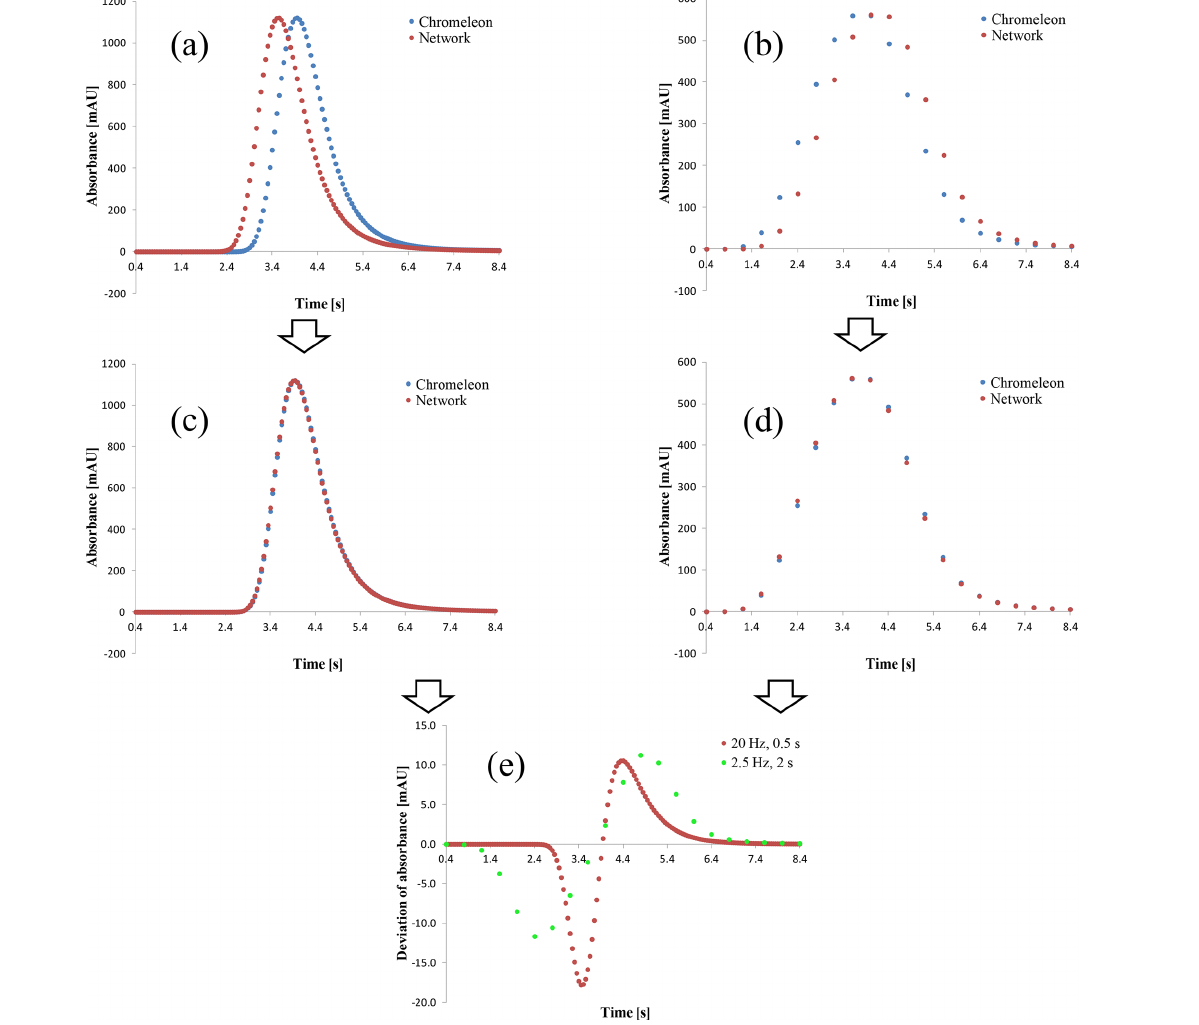
Figure 6. Comparison plots between Chromeleon ® and the caught data packages of the network generated by HPLC system B. (a) Raw data of 20Hz without data averaging, (b) raw data of 2.5Hz without data averaging, (c, d) time shift of the network data to align the peak apexes, and (d) deviation as the difference between the chromatograms in (c, d) computing Chromeleon ® data − network